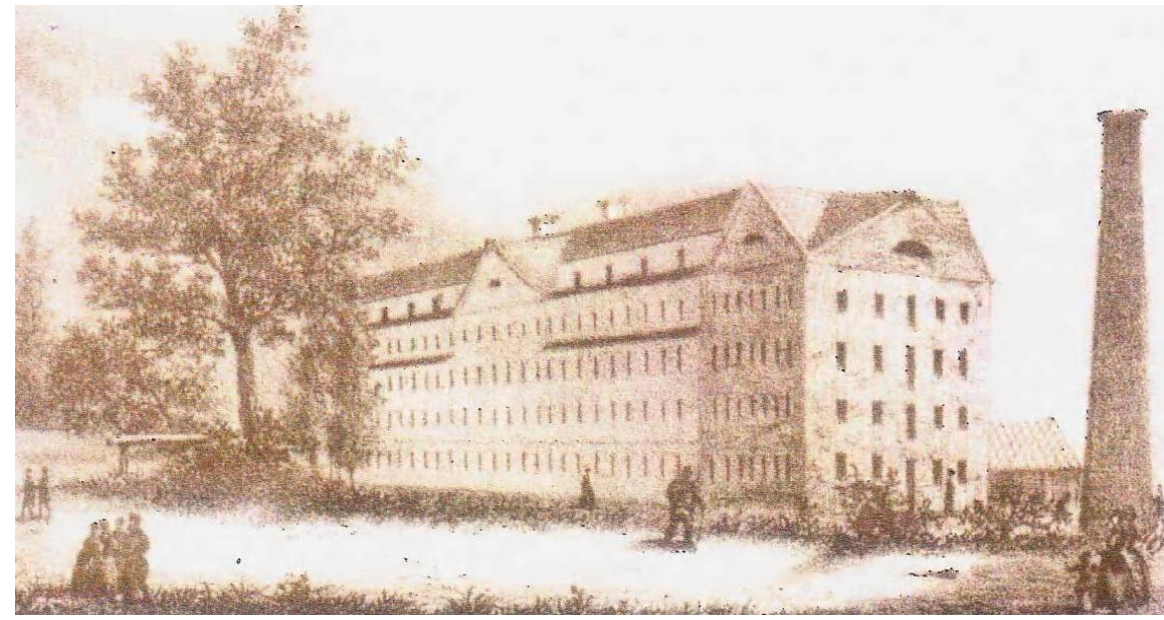
Fig. 6. T. Kopisch whitewashing plant from 1828 at 5 Tymienieckiego Street ( A. Kurycki )